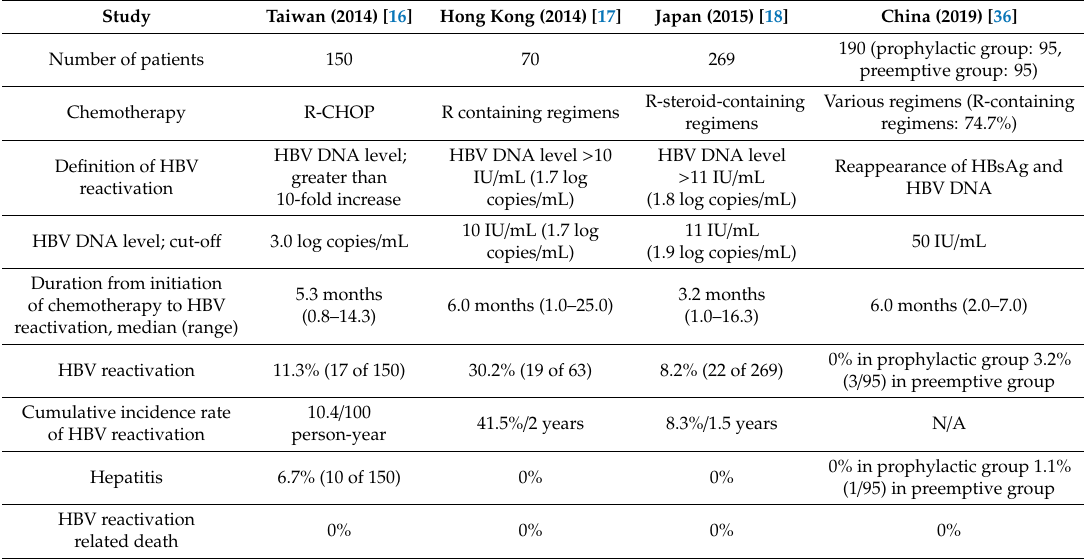
Table 3. Prospective studies on HBV reactivation in malignant lymphoma